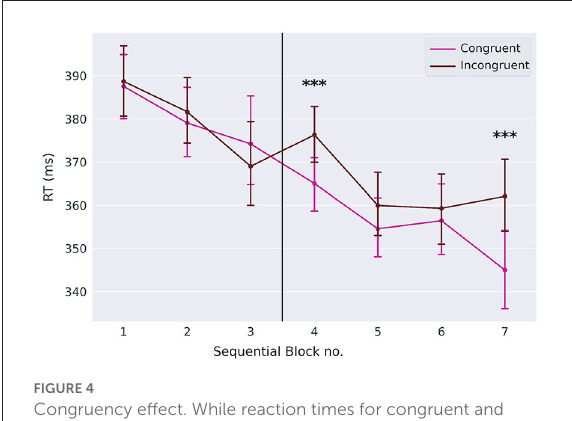
FIGURE4 Congruency effect. While reaction times for congruent and incongruent trials are not different on day one, they are different in blocks four and seven on day two. Error-bars show standard errors of the means. The *** symbol indicates the value of p <